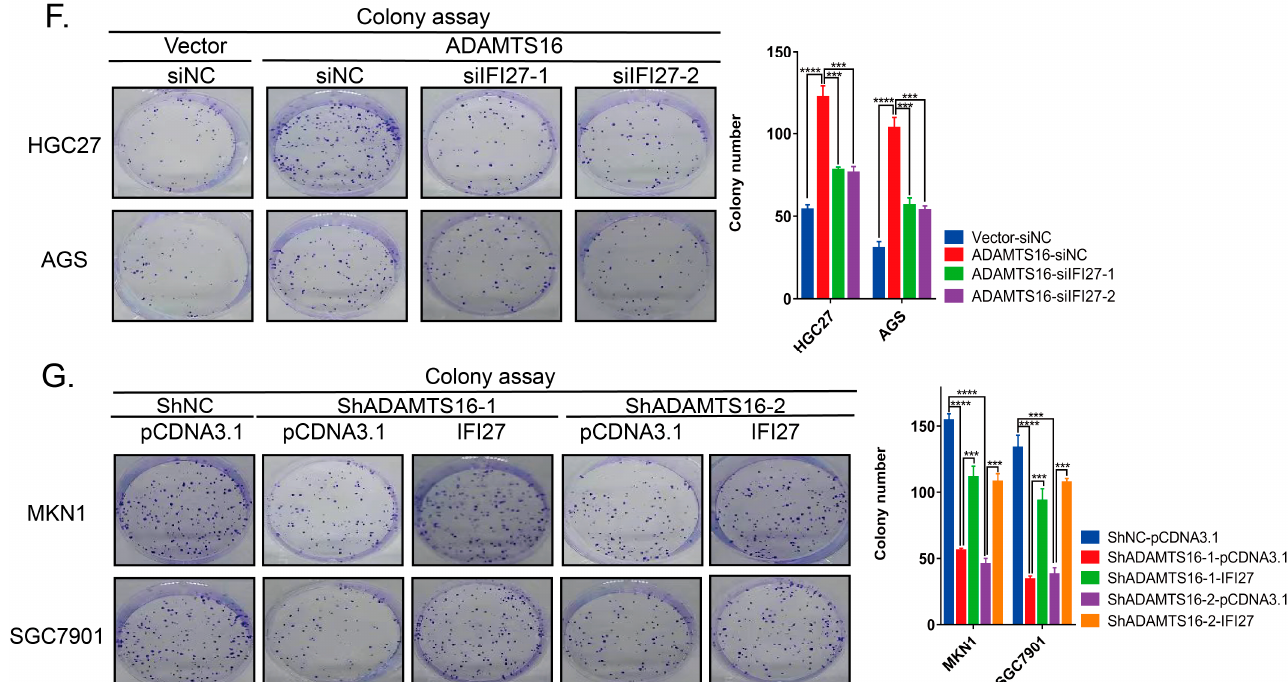
Figure 4. IFI27 protein knockdown reverses ADAMTS16-induced GC cell promotion. ( A ) Western blot and quantitation analysis of IFI27 in stably ADAMTS16-transfected HGC27 and AGS cells and stably knockdown ADAMTS16–transfected MKN1 and SGC7901 cells. ( B – E ) Transwell assays were performed to assess cell migration and invasion in the indicated cell lines (original magnification: 200×). ( F , G ) colony formation assays were performed to assess cell colony formation and proliferation ability in the indicated cell lines. Scale bar, 50 µm. The data are shown as means ± standard deviations. * p < 0.05, ** p < 0.01, *** p < 0.001, **** p < 0.0001. ns, not significant.